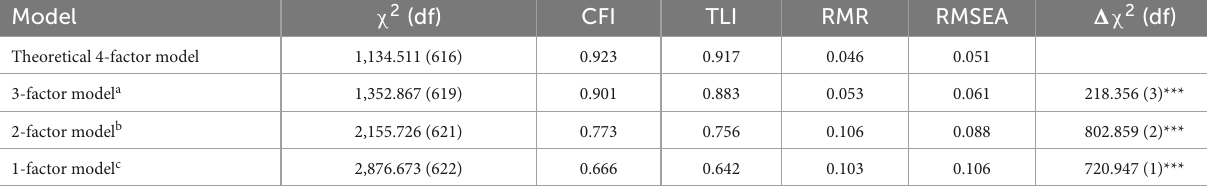
TABLE 2 A confirmatory factor analysis for comparison of measurement models.